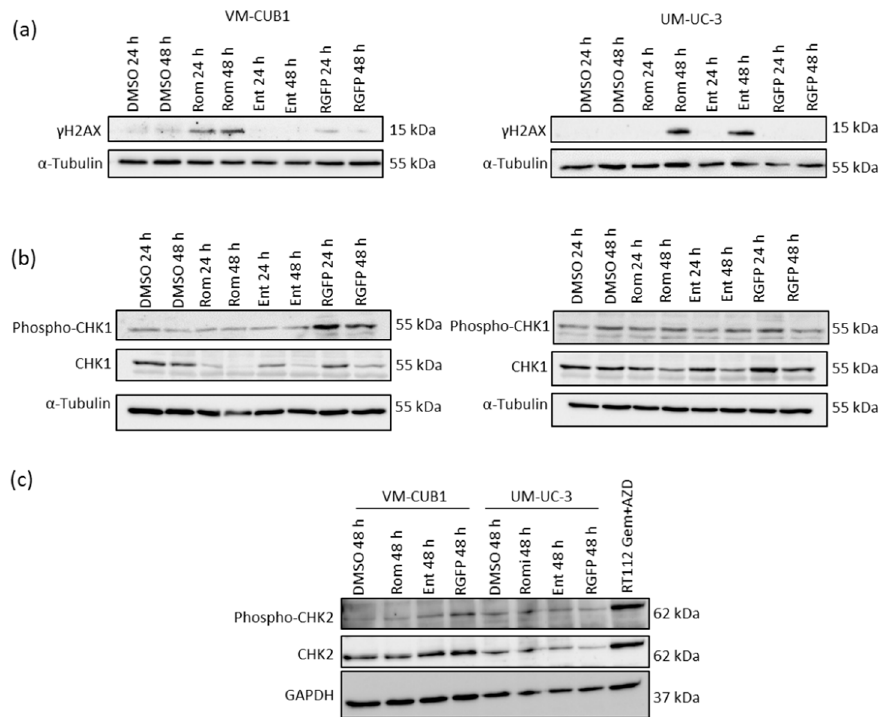
Figure 7. Analysis of DNA damage and according checkpoint signaling after treatment with HDACi. ( a ) Phosphorylation of γ H2AX at Serin 139 was detected by western blotting after treatment with indicated HDACi for 24 h and 48 h. ( b ) Phosphorylated and total CHK1 protein was detected by western blotting after treatment with the indicated HDACi for 24 h and 48 h. α -Tubulin was stained as additional loading control. ( c ) Likewise, phosphorylated and total CHK2 was detected. RT112 UCC cells treated with Gemcitabine and AZD7762 (Gem+AZD) were used as a positive control for CHK2 activation [45] . α -Tubulin and GAPDH were stained as additional loading control.